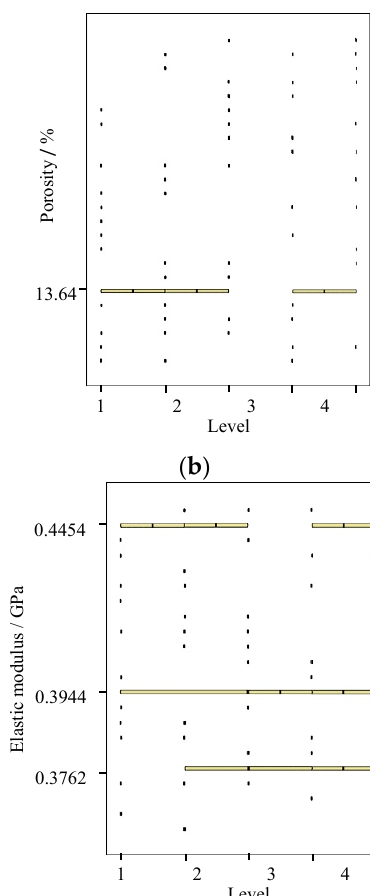
Table 15. Durbin Watson coefficient of multiple linear regression analysis.